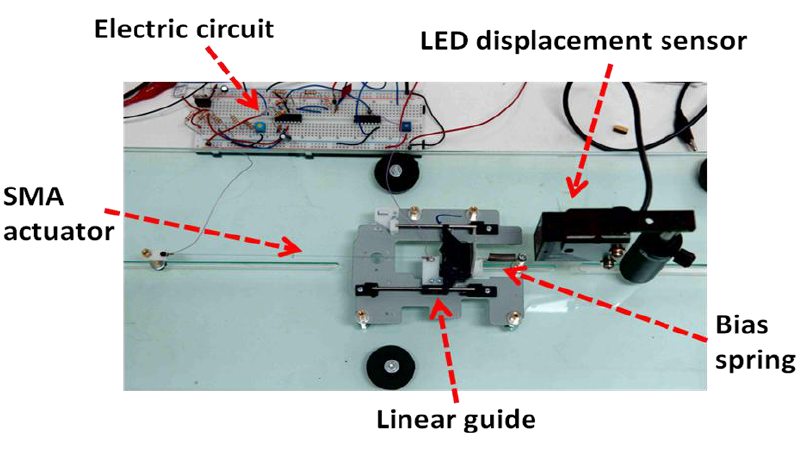
Figure 1. Experimental setup.